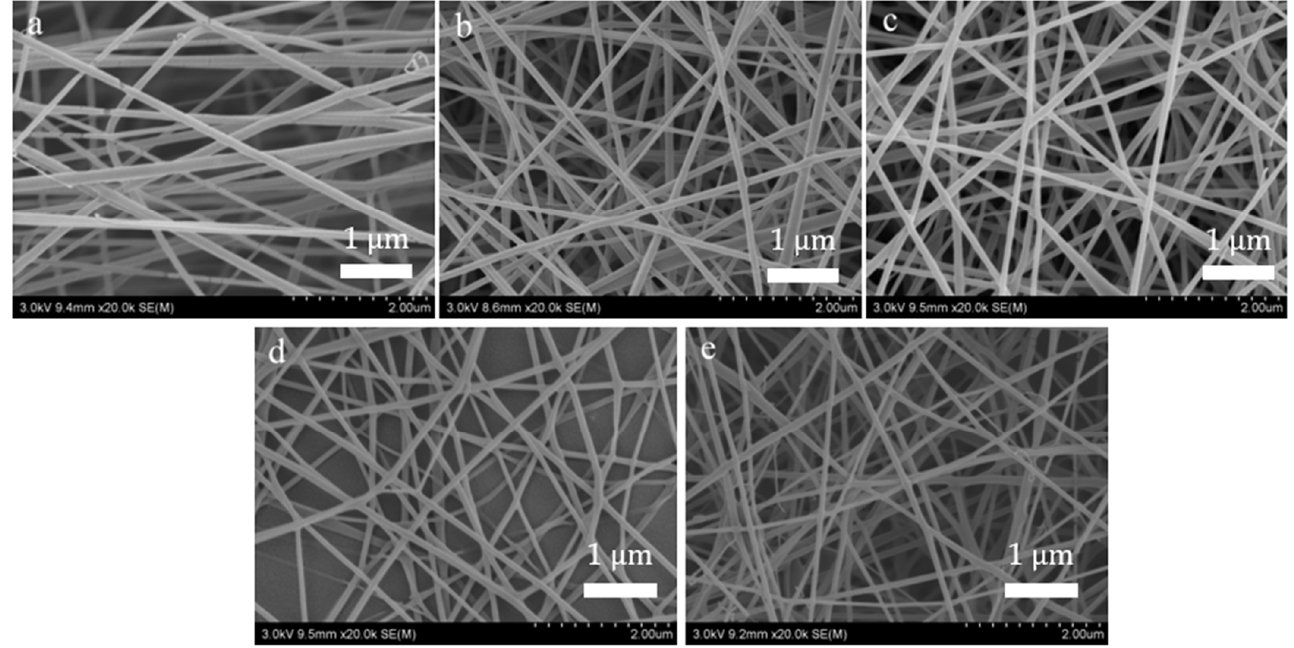
Figure 7. SEM of nanofiber, ( a ) PVA, ( b ) PVA with 0.5 g carbon nanoparticles, ( c ) PVA with 1 g carbon nanoparticles, ( d ) PVA with 1.5 g carbon nanoparticles, ( e ) PVA with 2 g carbon nanoparticles.